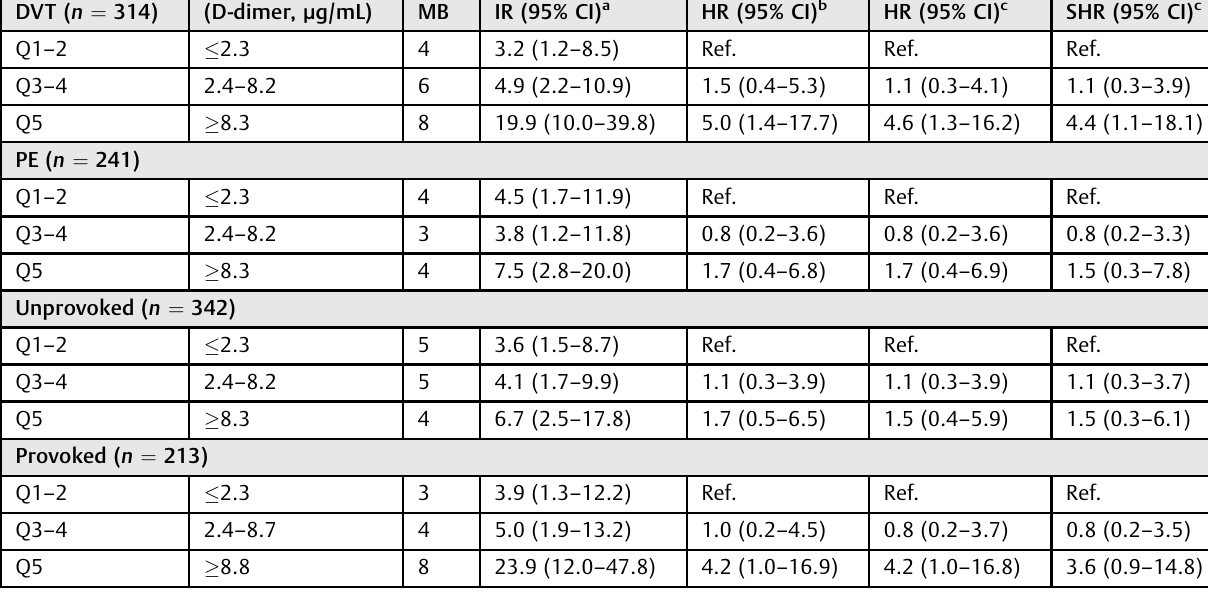
Table 4 Incidence rates (IRs) and risk of major bleeding (MB) by categories of D-dimer in subgroups of venous